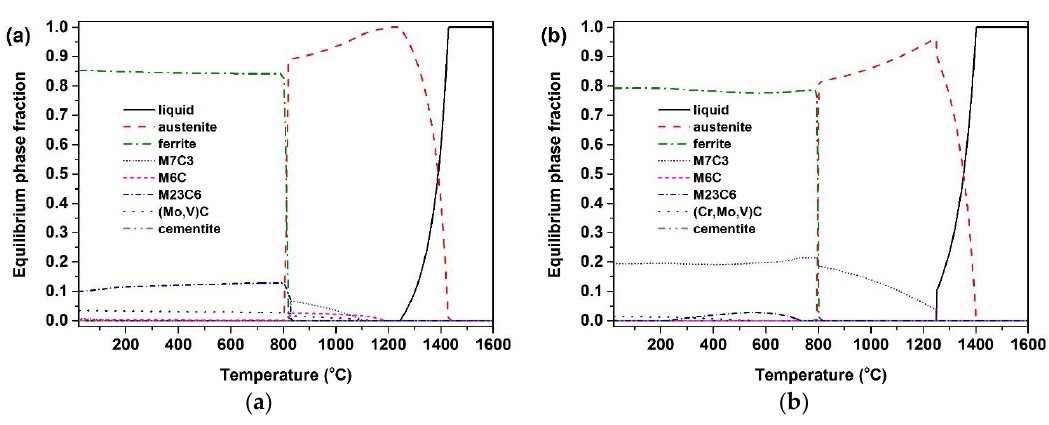
Figure 1. Equilibrium phase fractions calculated by using MatCalc (ver. 5.62) for the two steels: ( a ) Cr6C9 and ( b ) STD11.